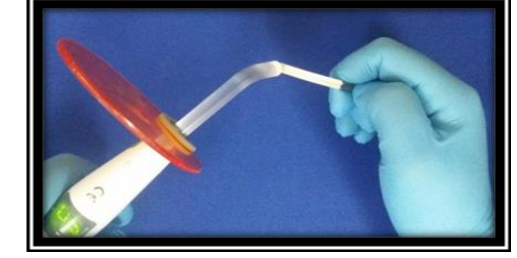
Fig. 1: Uniting the ten halves of the coated archwires segments together by light cure composite resin